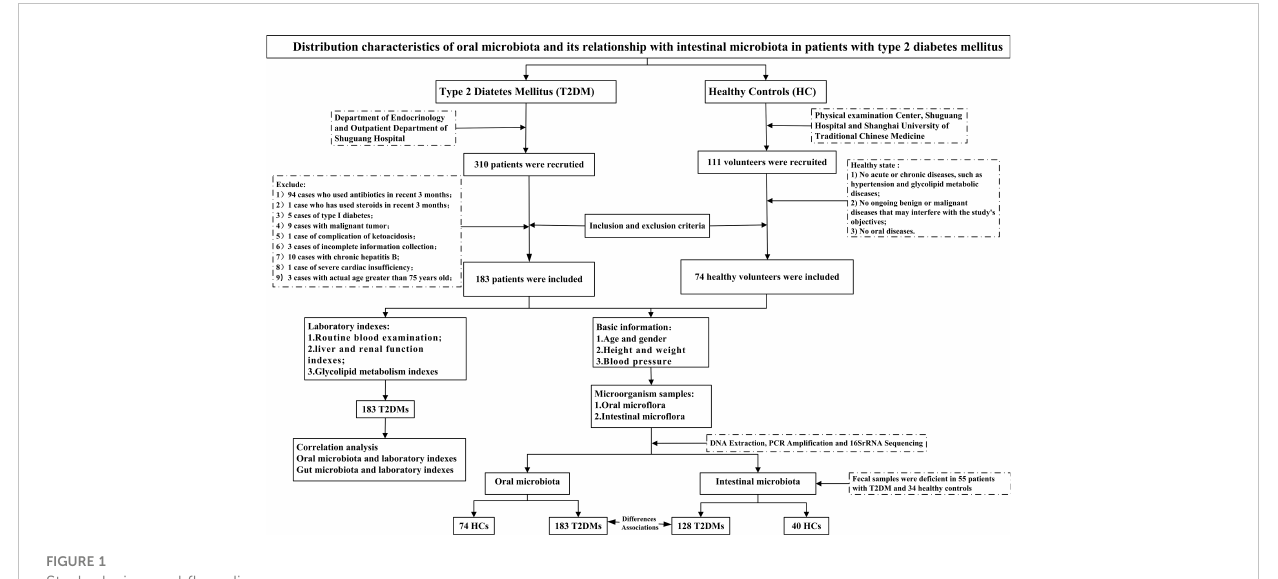
FIGURE 1 Study design and fl ow